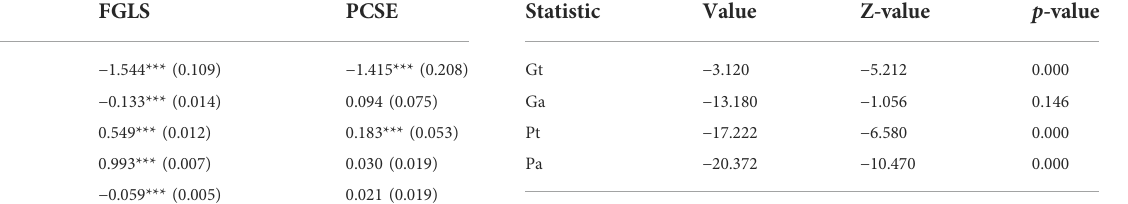
TABLE 3 Test results after the correction.